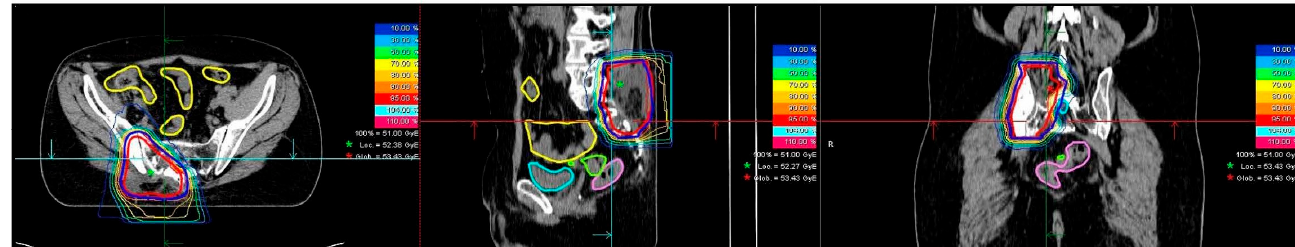
Figure 1. ( A – C ): Examples of three patients with primary pelvic Ewing sarcoma undergoing proton therapy.